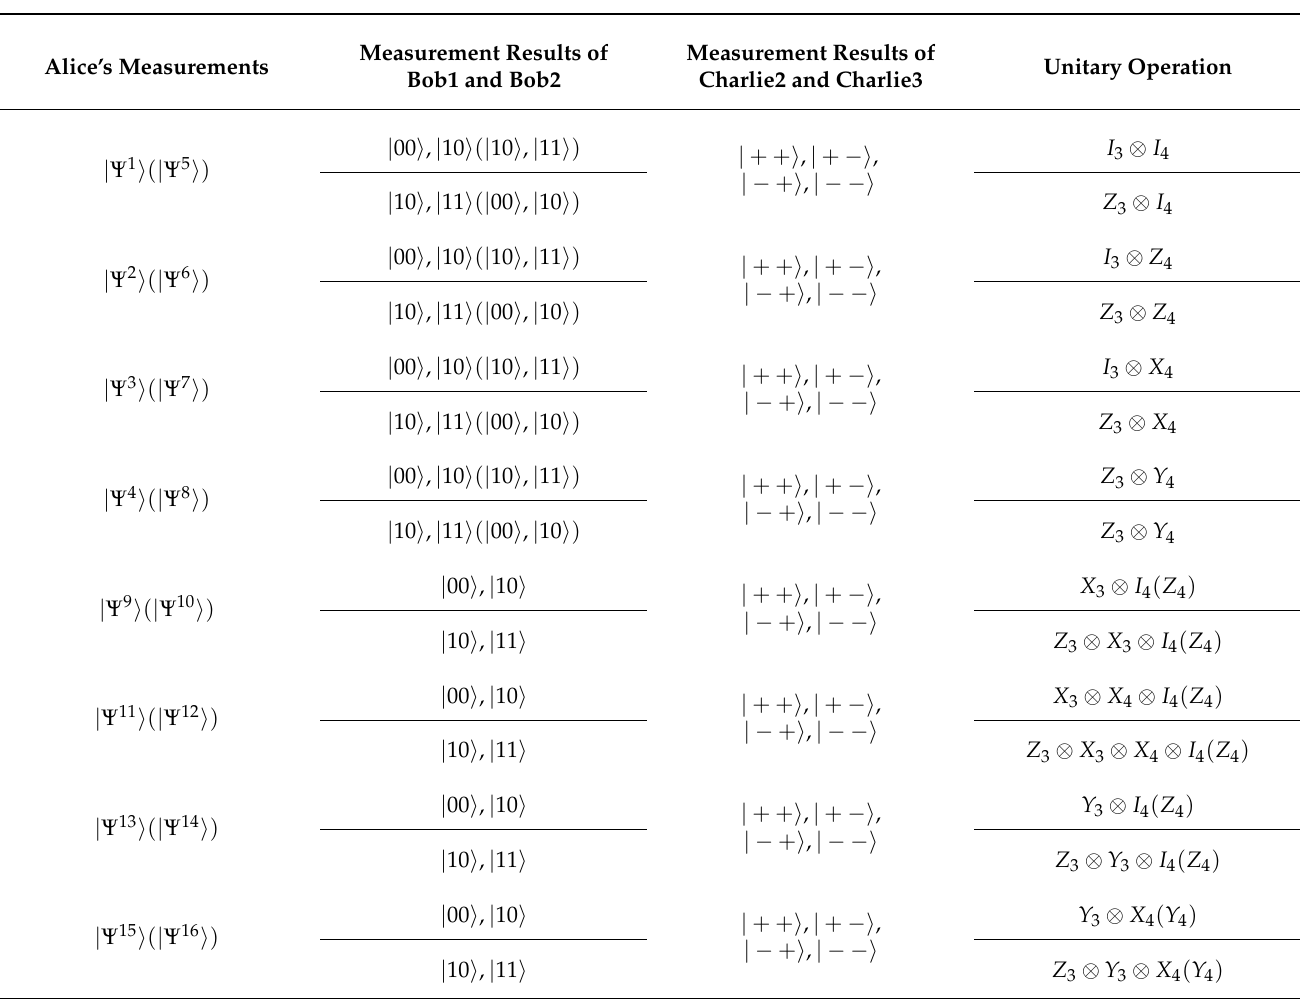
Table 6. Alice, Bob1, Bob2, Charlie2, and Charlie3 perform the measurement and the corresponding unitary operation of